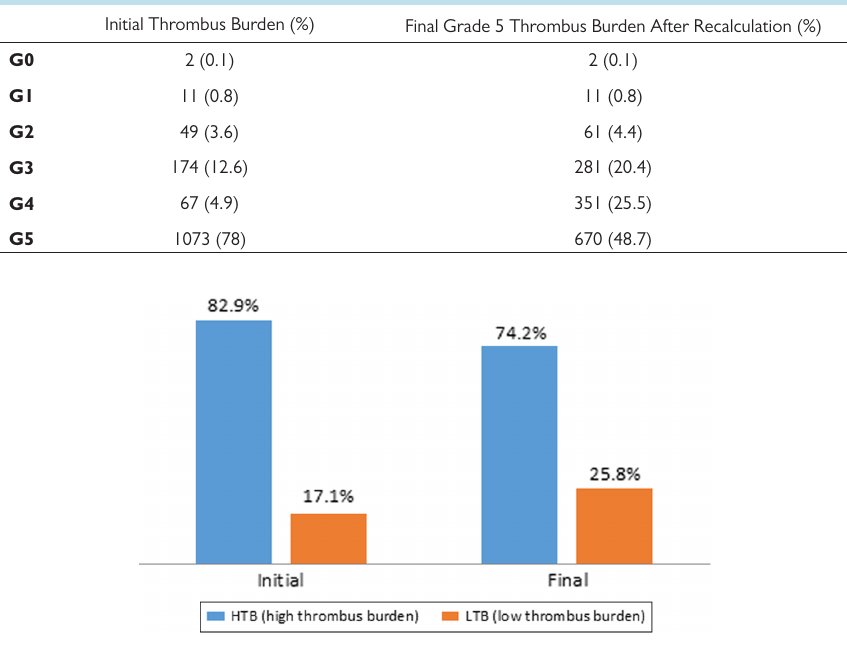
Table 2. Distribution of Initial and Final Thrombus Burden After Recalculation of TIMI Thrombus Grade 5